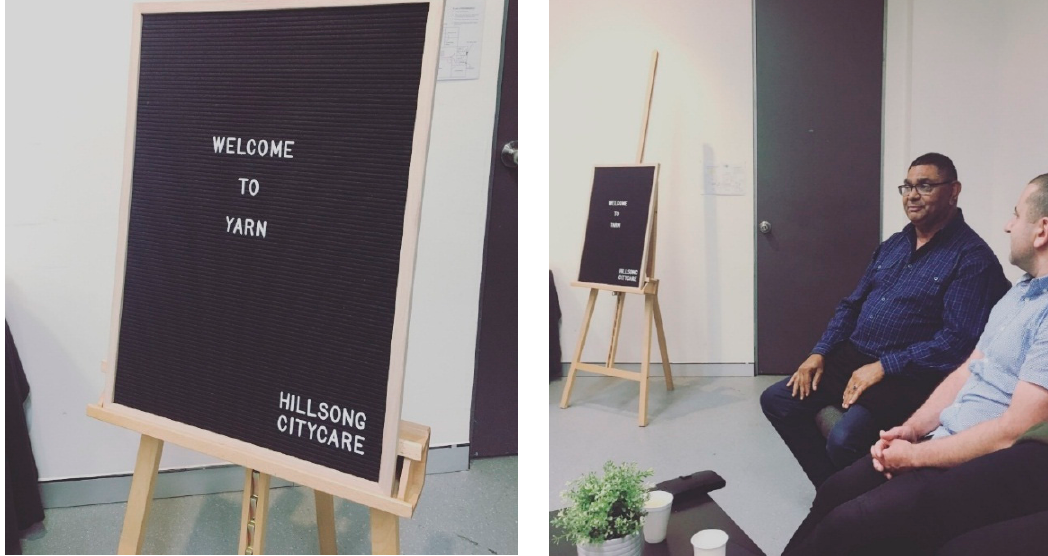
Figure 1. The initial yarning conversation at Hillsong’s Waterloo campus.